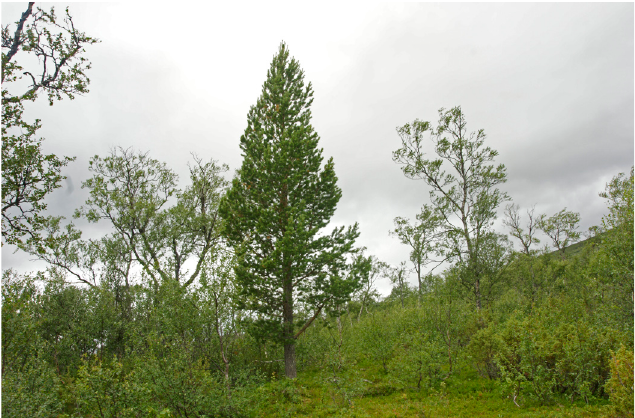
Figure 32: A solitary pine, which has become established in the birch forest belt. Obviously, it has benefited from local drought-induced birch forest regression. A sparse cohort of small saplings (not visible) has become established within a ra- dius of about 10 m. Mt. Getryggen 750 m a.s.l. 12 August